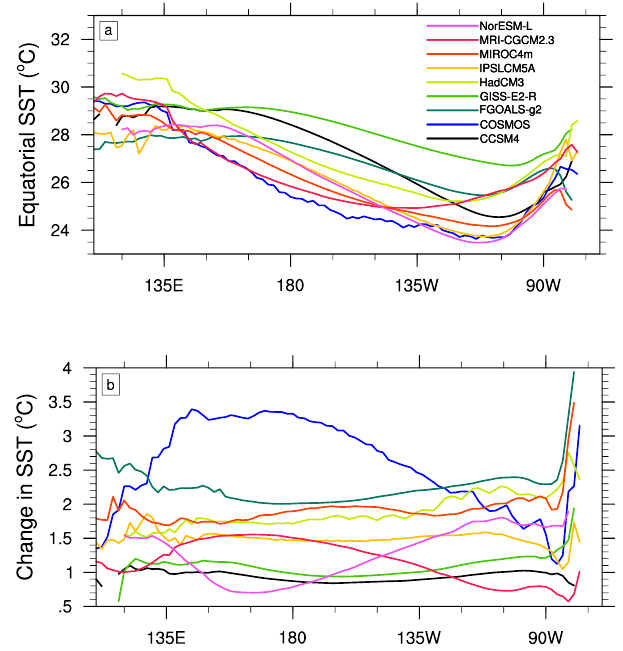
Figure 7. The annual mean Pacific temperature gradients along the Equator in the preindustrial simulations and the change in the Pliocene simulations.